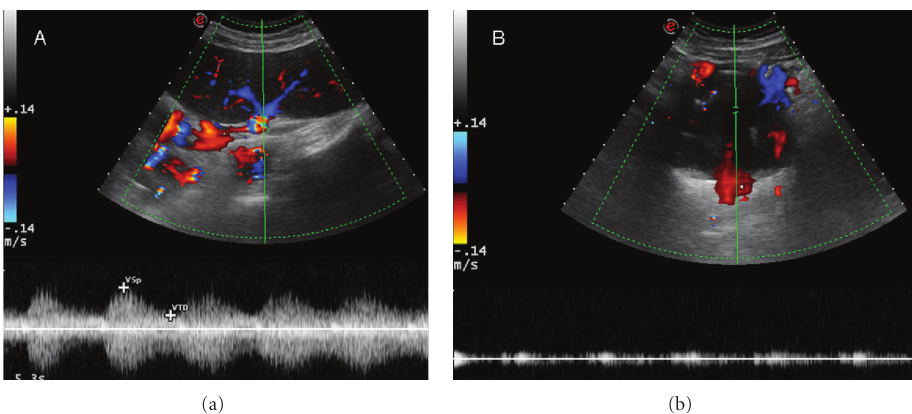
Figure 3: Abdominal ultrasound confirming the exclusion of the SAAs with complete preservation of distal flow to the spleen.